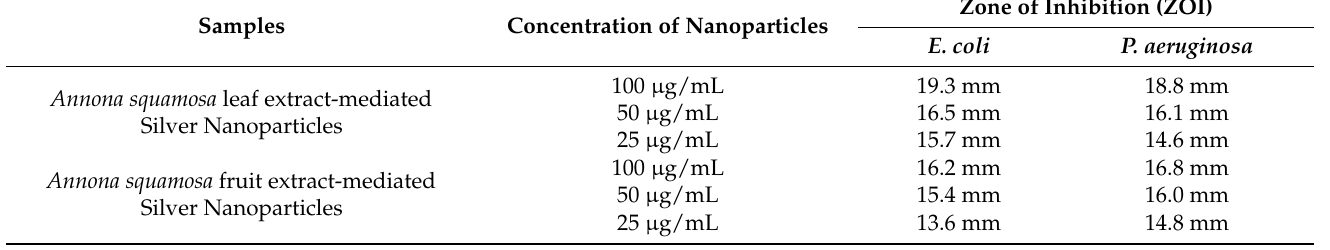
Table 2. Antibacterial activity of Annona squamosa leaf and fruit extract-mediated silver nanoparticles by forming ZOI.